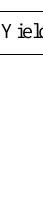
yield obtained in this study, errors quoted are at the 1 σ level of